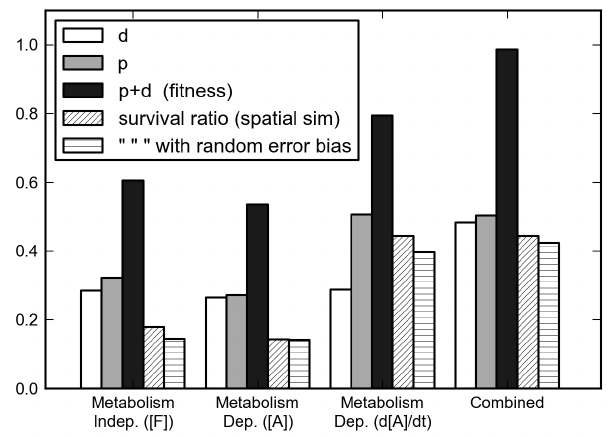
Figure 3. Evaluation of behaviors. The black columns indicate the fitness of each behavior as evaluated by the fitness function. Fitness is the sum of two terms: p , the proportion of tested initial conditions that are survived by the behavior and d , a normalized score that describes the mean distance of the final concentration of A from the death states for all tested initial conditions (higher is better for all measurements). See Section 2.2 for further details of how these scores were calculated. Also plotted are the proportion of survival in the spatial simulations (see Section 3.5). Note that the spatial model survival rates follow a similar pattern to the fitness evaluation in the more abstract